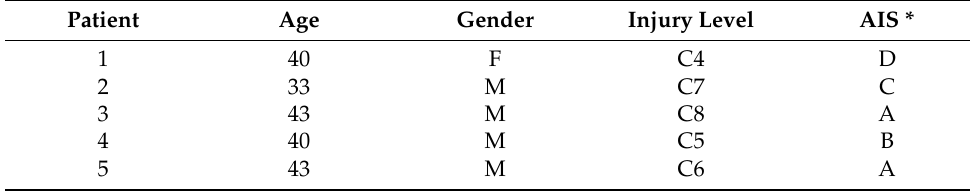
Table 2. Spinal Cord injured patients’